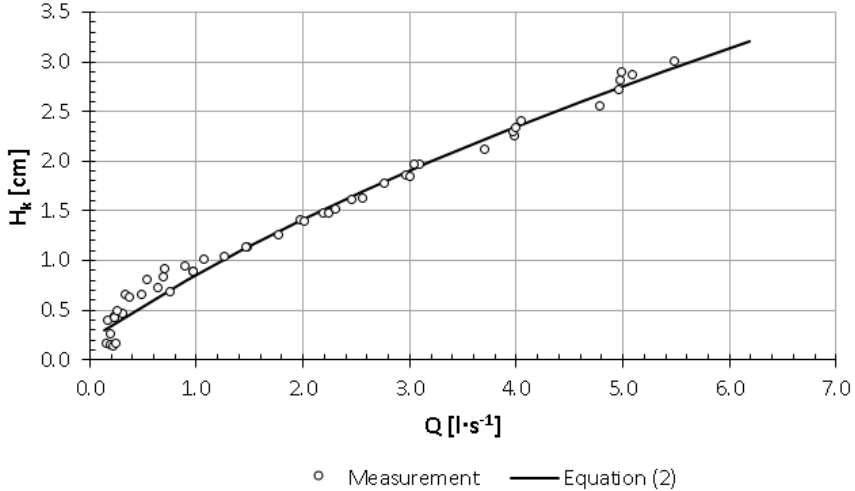
Figure 6. Cumulative curve of the overflow discharge Q of the funnel regulator at different values of H k .